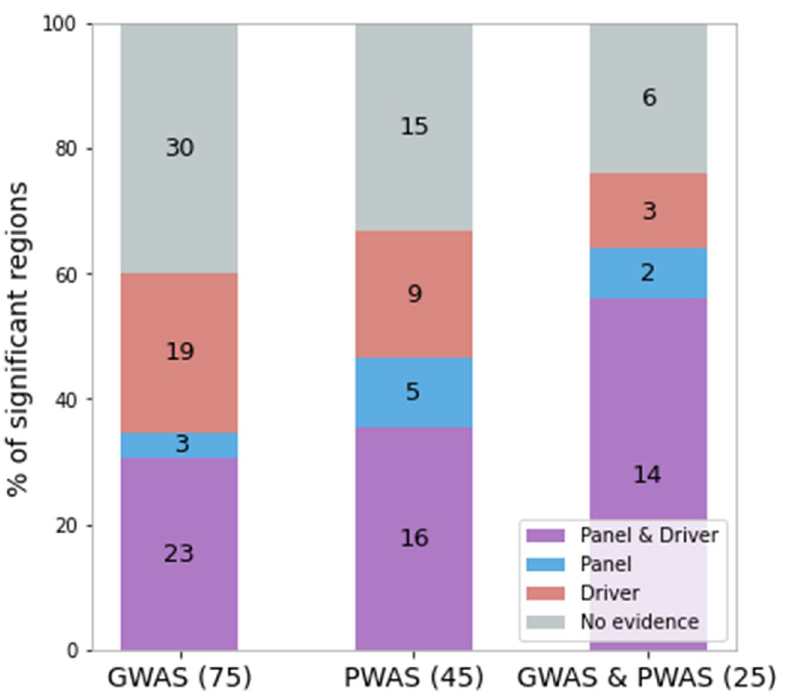
Figure 3. External evidence supporting the cancer predisposition regions. Partitioning of the 145 significant cancer genomic regions according to which method found them (GWAS, PWAS or both) and supporting evidence (overlap with clinical cancer gene panels, driver cancer genes, both, or